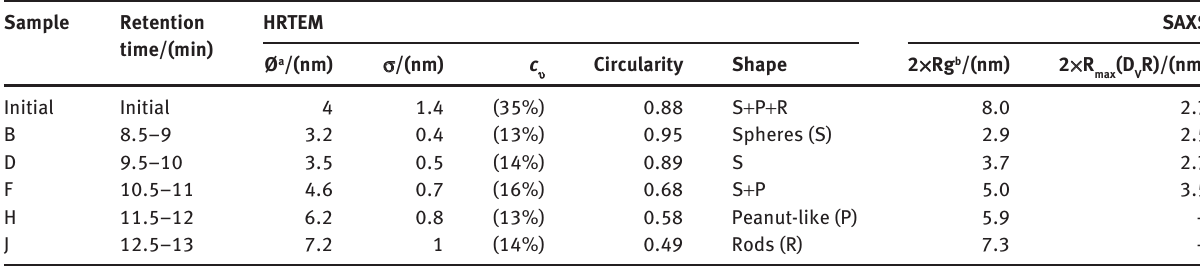
Table 1 The comparison of the TEM and SAXS results for the different fractions.